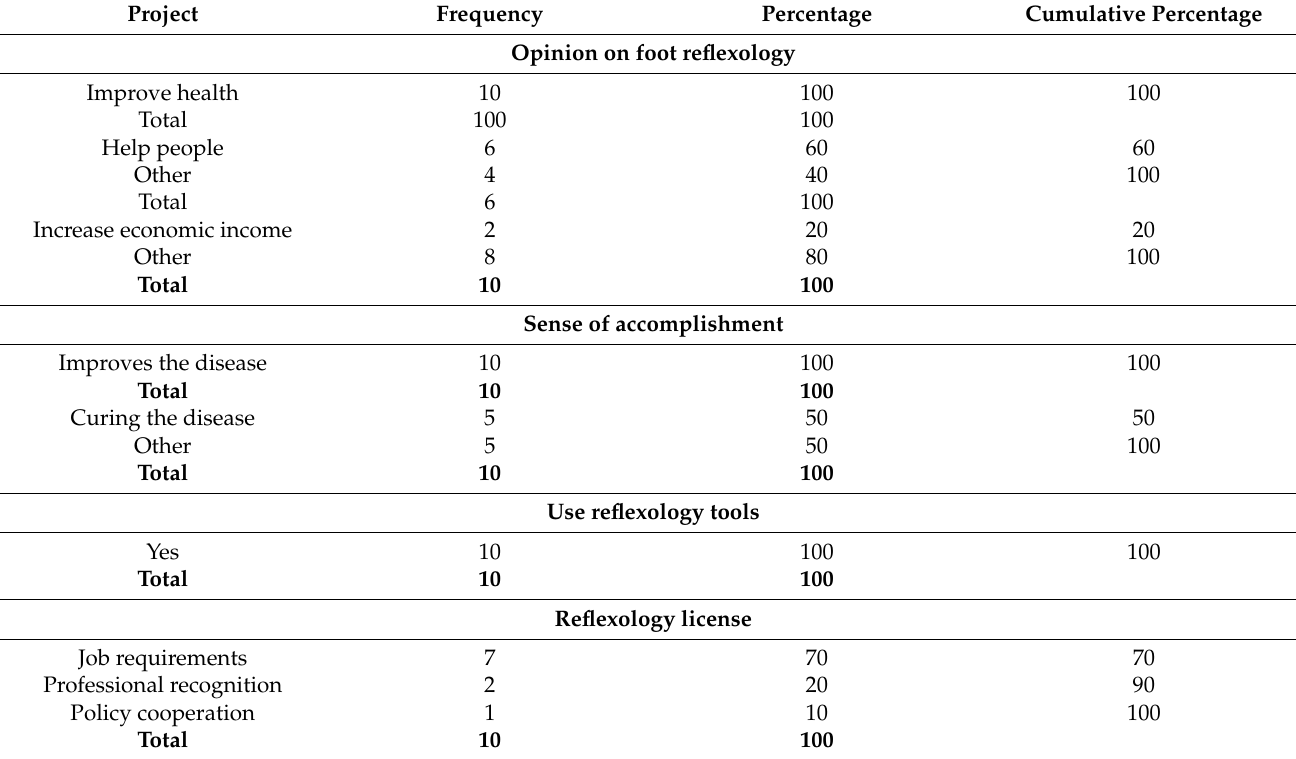
Table 5. Survey results related to the interview of the